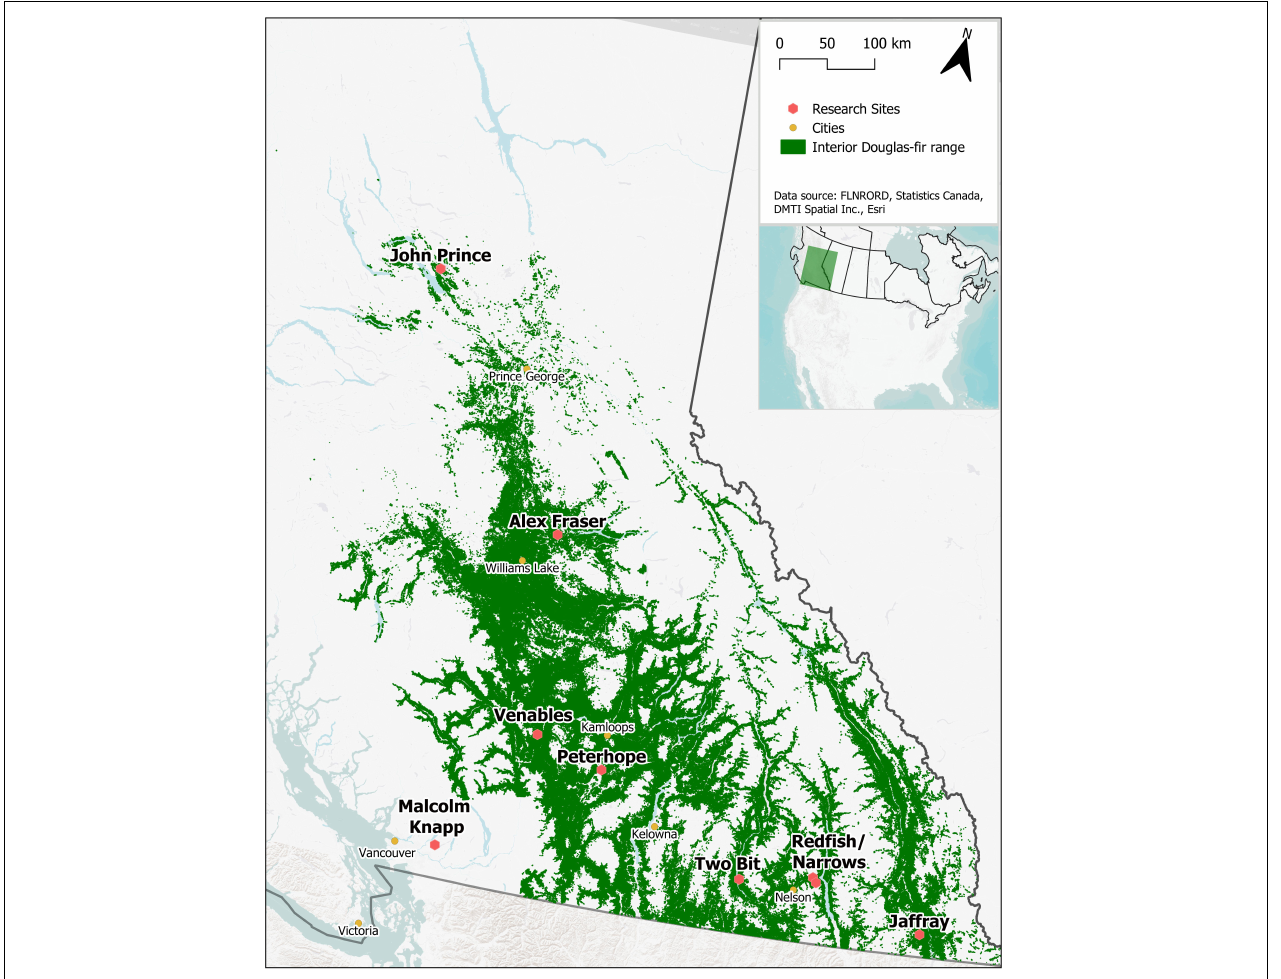
FIGURE 1 | Location of the nine research sites. Green indicates the current distribution of Interior Douglas-fir in British Columbia.